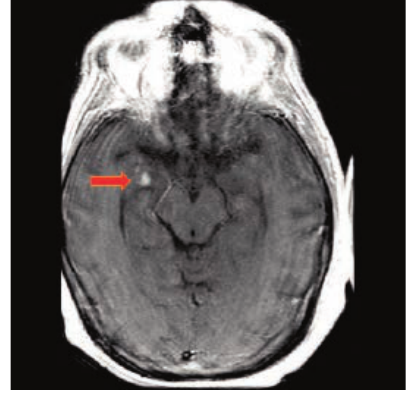
Figure 2. T2-weighted MRI obtained on HD11 of second admission, demonstrat- ing punctate areas of restricted diffusion, most likely small areas of infarct consis- tent with post-infectious